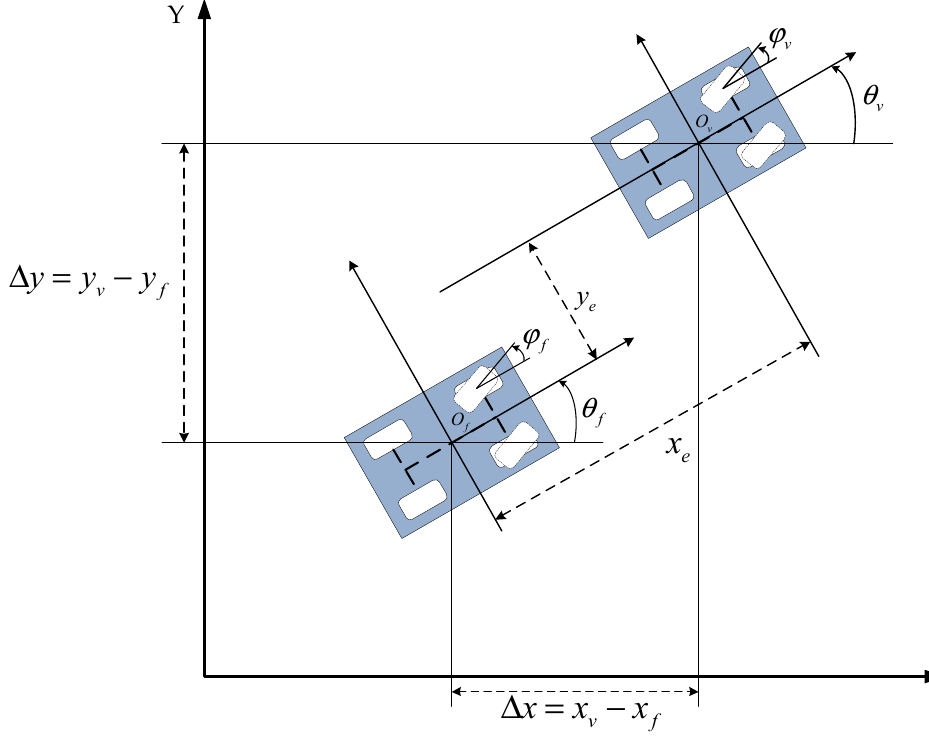
Figure 7. Simple diagram of leader-follower system